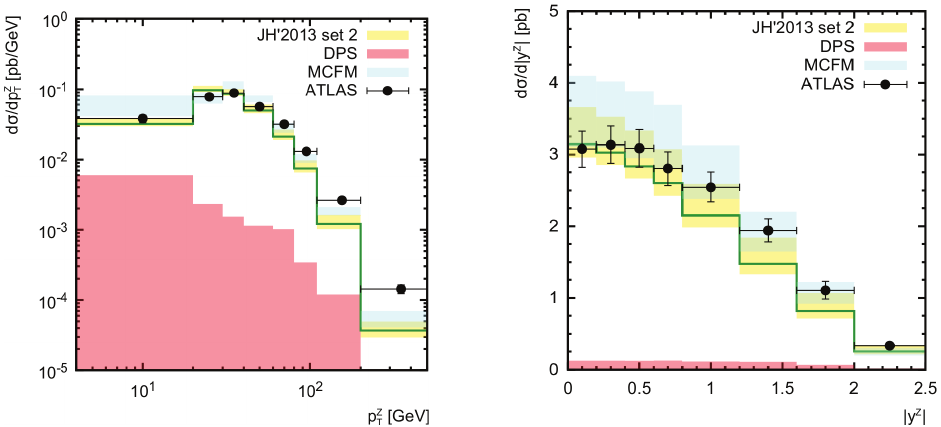
Figure 1. Associated Z + b production cross section at √ s = 7 TeV presented as a function of the Z boson transverse momentum (left panel) or rapidity (right panel). Solid histograms show our predictions at the default scale while shaded bands correspond to scale variations described in the text. The estimated DPS contributions and MCFM [28] predictions (taken from [3]) are shown additionally. The data are from ATLAS